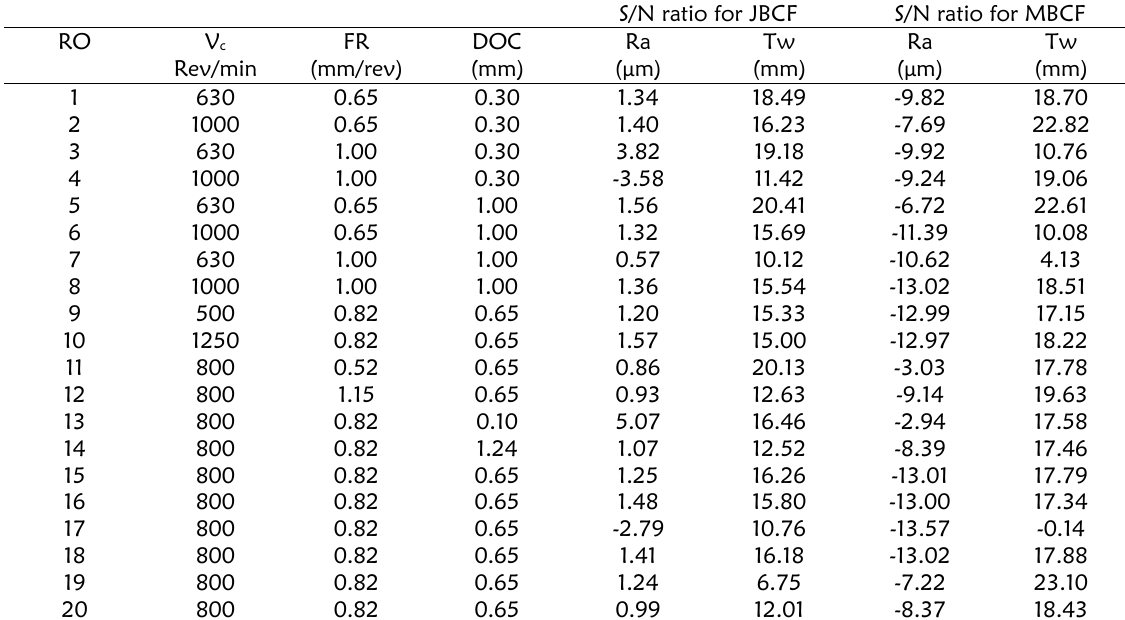
Table 11: S/N ratio for Surface roughness and Tool wear S/N ratio for